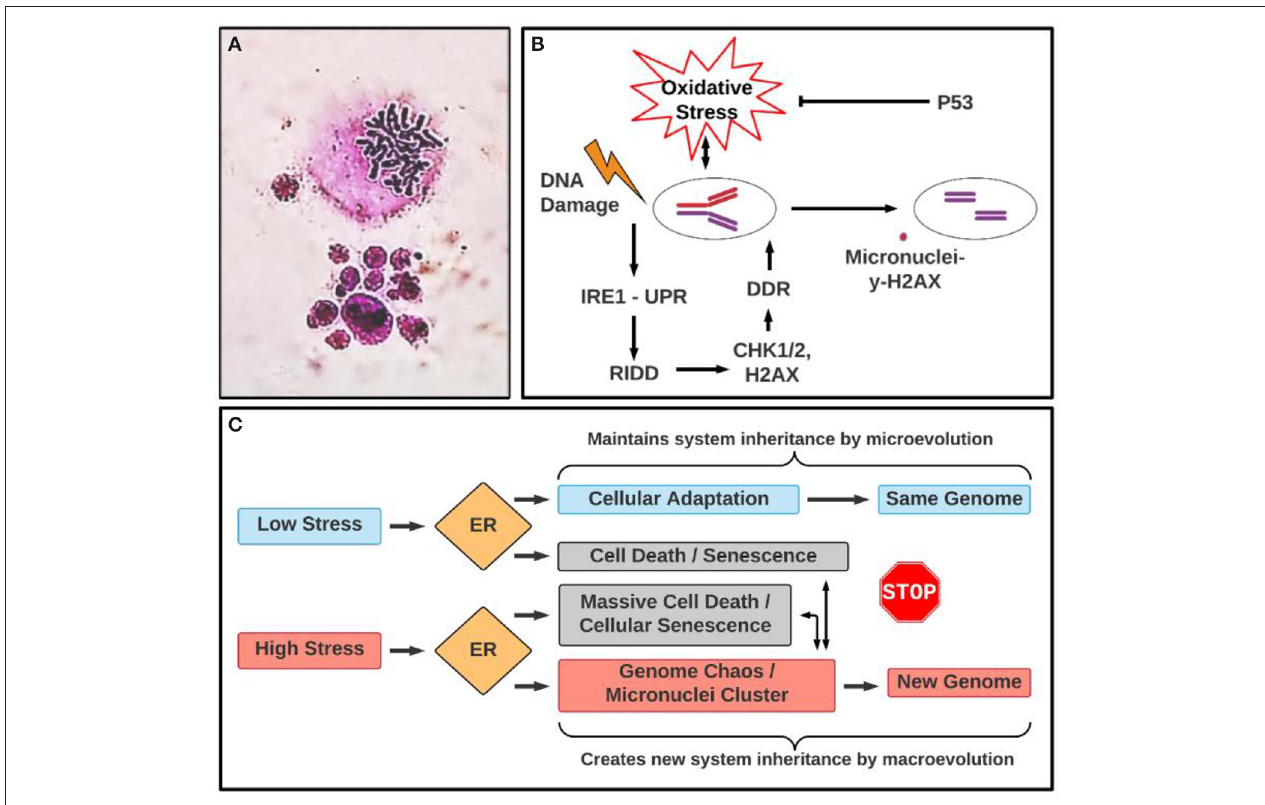
FIGURE 1 | Micronuclei cluster: morphology and involved pathways in ER stress. (A) Example of micronuclei cluster. The upper image is a mitotic figure and the lower image is a micronuclei cluster where different sized nuclei clustered with each other. Mitotic figure and micronuclei cluster was stained by Giemsa. (B) Illustrating a link between oxidative stress, unfolded protein response (UPR) and micronuclei formation under genotoxic stress. DDR, DNA damage response; RIDD: IRE1 α -dependent decay. (C) A proposed conceptual relationship between different types of stresses, ER stress response, the types of evolution (macroevolution vs. microevolution). Even though ER response acts differently according to low and high stress, which are linked to microevolution and macroevolution, respectively, they are overlapping in terms of leading to senescence and genome chaos. For example, while high stress often can induce genome chaos including micronuclei clusters and senescence, coupling with massive death, low stress also could lead to death and senescence, which can lead to genome reorganization, albeit at a much lower rate. The association between senescence and ER stress response (UPR) is context-dependent. Indeed, senescence and ER stress response (UPR) make an interconnected network (UPR is activated in consequence to cell senescence or UPR is a driver of senescence) in which oxidative stress (ROS) acts as a central element responsible for an auto-amplification loop (Pluquet et al., 2015). The conceptual basis of this model is stress-induced genome reorganization that is essential for somatic evolution. Cellular stress in general, and ER stress in particular, can serve as an informational code that determines the cell’s fate (Heng and Heng, 2021). Depending on the stress intensity or duration, UPR can trigger diverse cellular responses, including apoptotic pathways, which can be linked to genome chaos with the involvement of micronuclei clusters. This model also predicts the complex relationship between the UPR, genome reorganization, and functional relevance in cancer immunobalance. Even though the UPR may promote genome reorganization under acute or severe stress conditions, newly formed genomes can either be favorable or unfavorable for cancer cell malignancy depending on the genomic context. For example, the newly formed genomes, including micronuclei clusters, could either activate the immune system to fight against cancer or instead help cancer unexpectedly. It was reported that cell fusion can occur between cancer cells and immune cells (such as macrophages), promoting cancer cells to become more aggressive (Gast et al., 2018). In fact, a German gynecologist, Otto Aichel, first introduced this idea in 1911. It is likely that fused hybrid cells change their genomes through genome chaos including micronuclei clusters. According to the Genome Architecture Theory, such a mechanism of genome information creation under stress should be a universal phenomenon. However, for future research direction, quantitative studies are needed to predict the clinical odds (beneficial or harmful) under different treatment